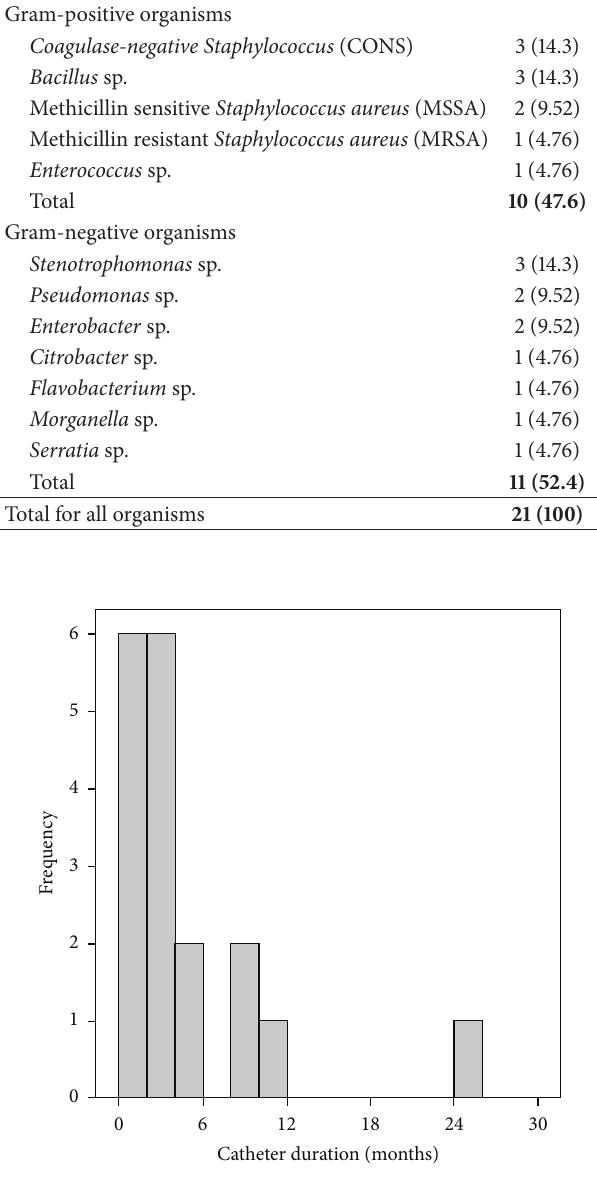
Figure 1: Haemodialysis catheter duration at the time of infection.